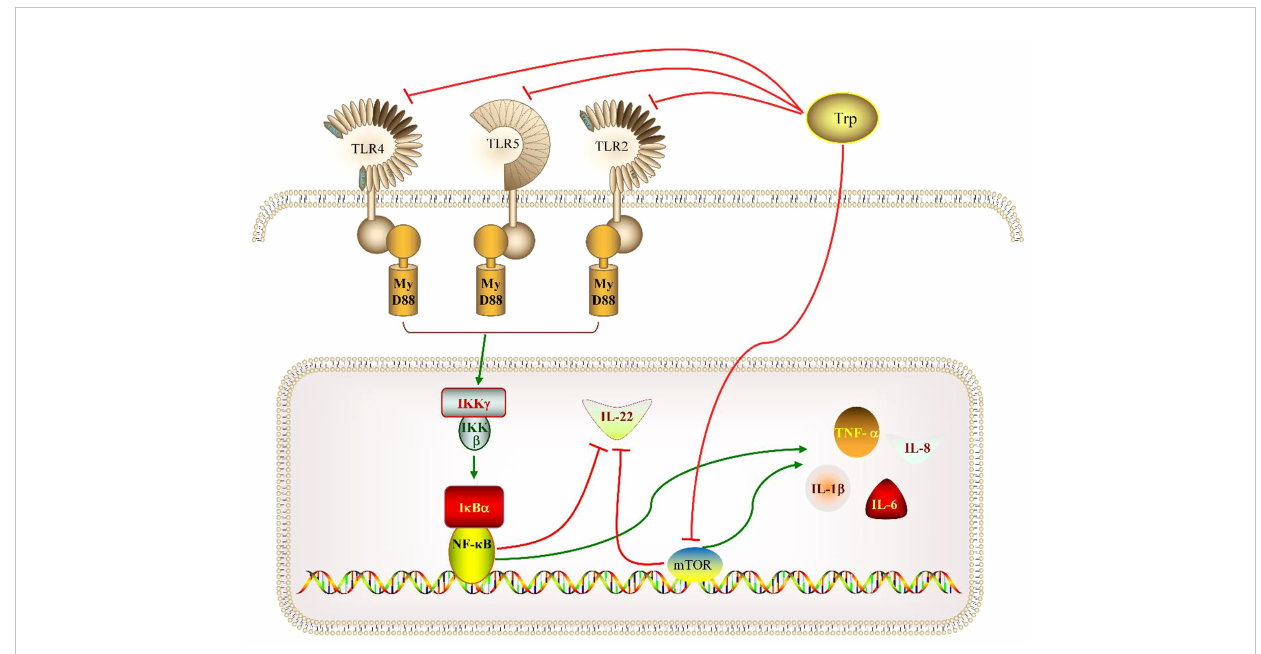
FIGURE 5 Possible mechanisms of the mechanisms of optimal dietary tryptophan promoted intestinal health via TOR and TLRs/MyD88/NF- k B signaling